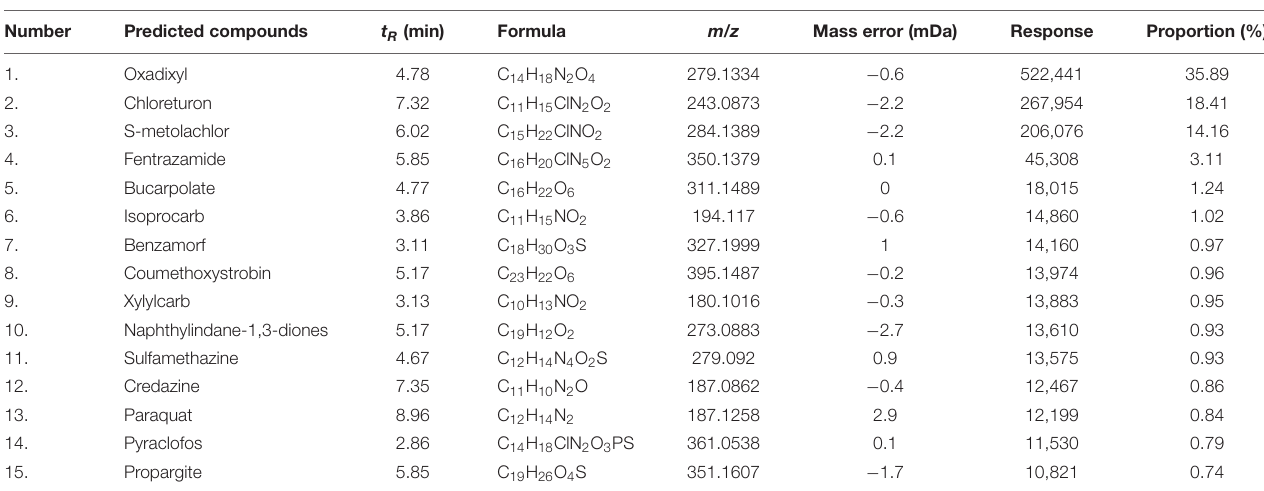
TABLE 1 | Compounds identified from the extracts of S. lydicus M01 by